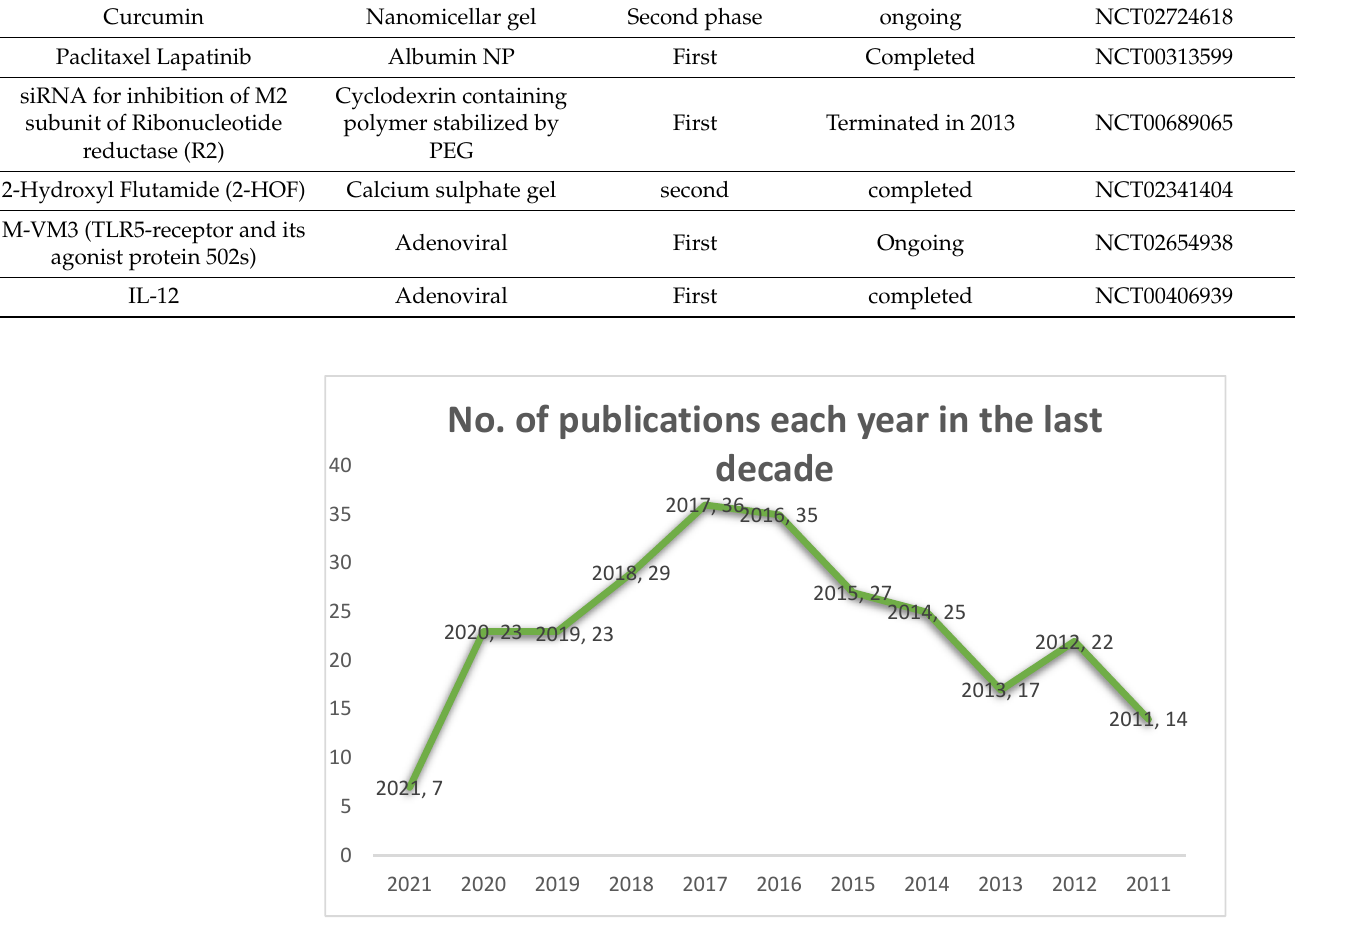
Figure 3. A graphical representation of the number of published articles relating to prostate cancer and nanoparticles drug delivery between 2011 and 2021. Table 3. Tabulation of the Nanoparticle currently used for prostate cancer, their bioactive ingredi- ents and targets.